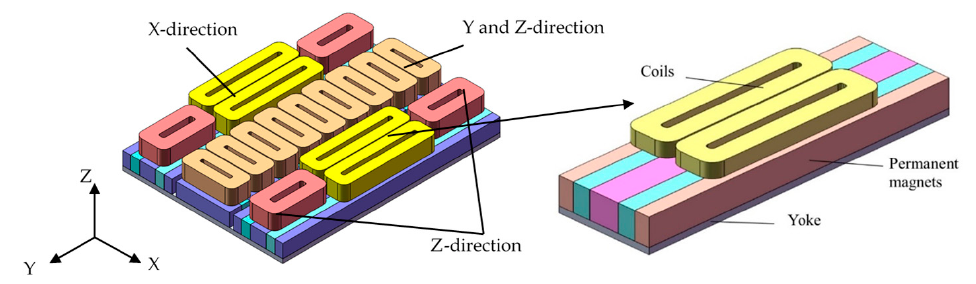
Figure 1. Schematic diagram of single-sided, coreless, flat-type linear voice coil motor.